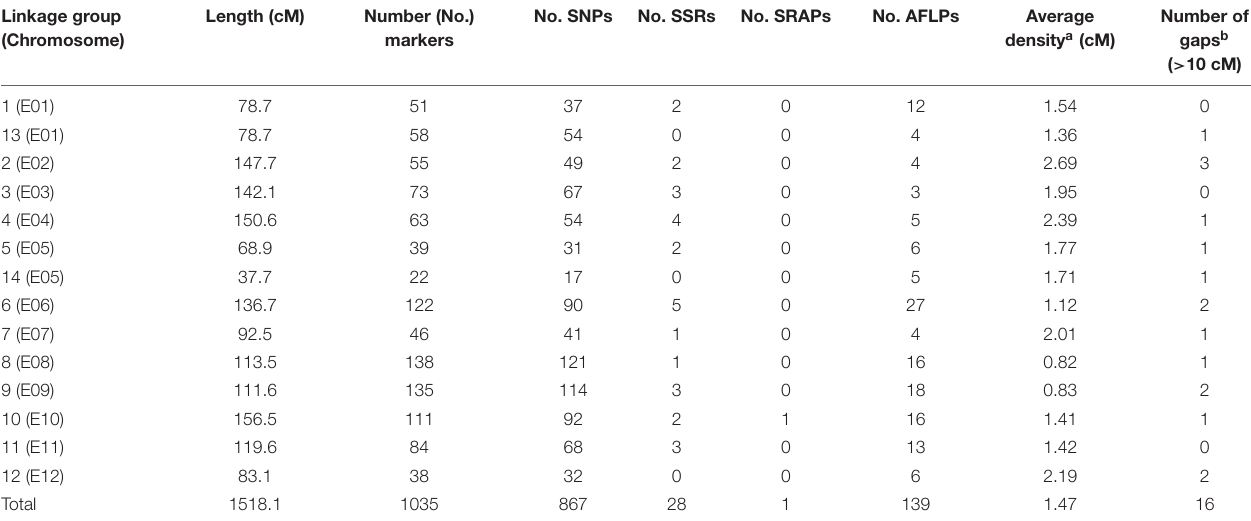
TABLE 2 | Statistics of the eggplant [MM738 × AG91-25] RIL population genetic map, including SSR, SRAP, and AFLP from previous work by Lebeau et al. (2013) and newly genotyped SNP markers. Linkage group (Chromosome)